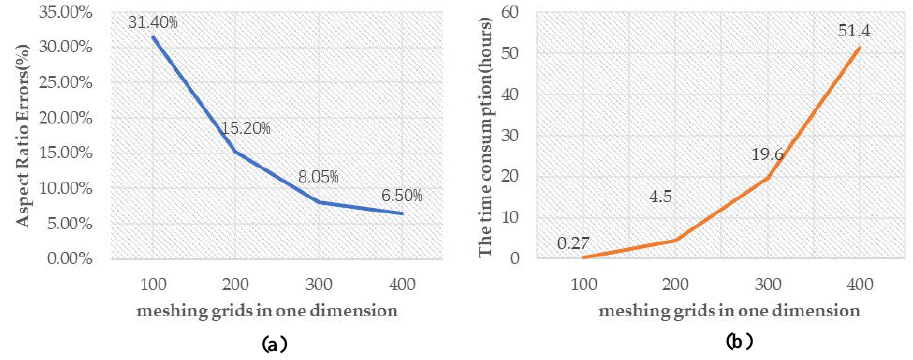
Figure 12. Line charts of aspect ratio errors ( a ) and runtime ( b ) simulating the porous structures in different